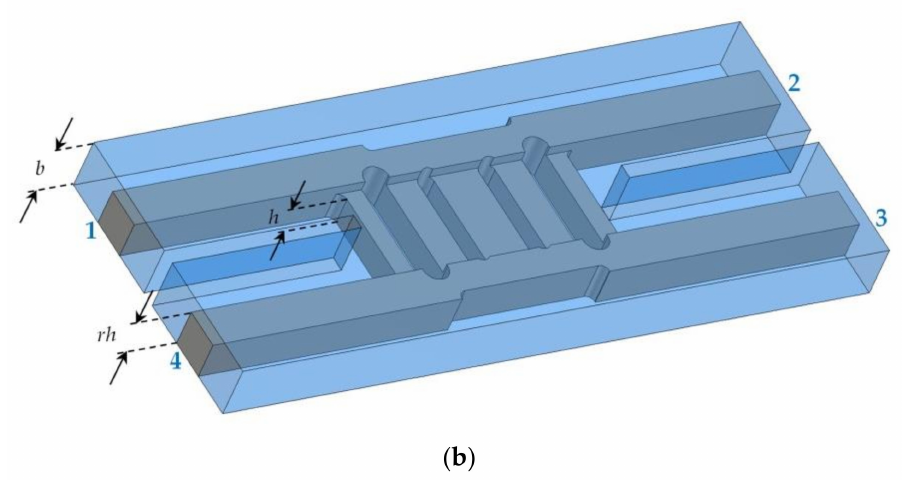
Figure 3. Hybrid coupler 2 (HC2) geometry. ( a ) Top view. ( b ) Three-dimensional view. Table 2. Hybrid coupler 2 (HC2) geometrical parameters.